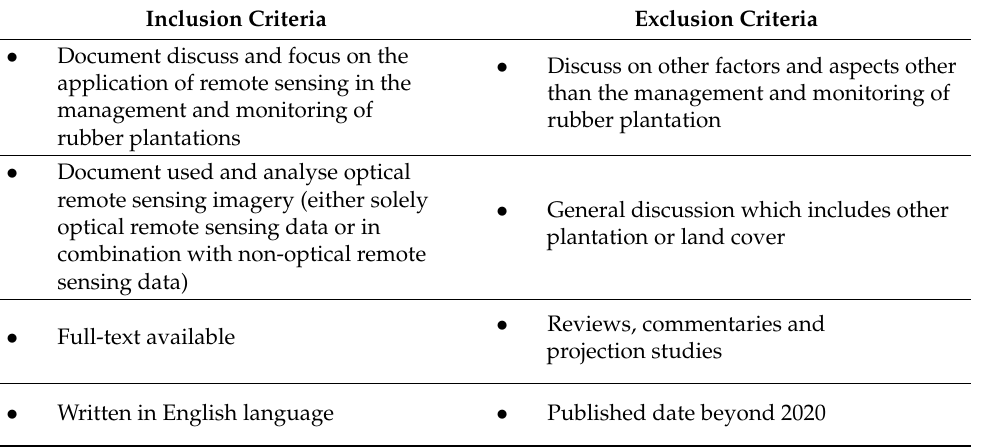
Table 1. Inclusion and exclusion criteria set for the selection of documents.